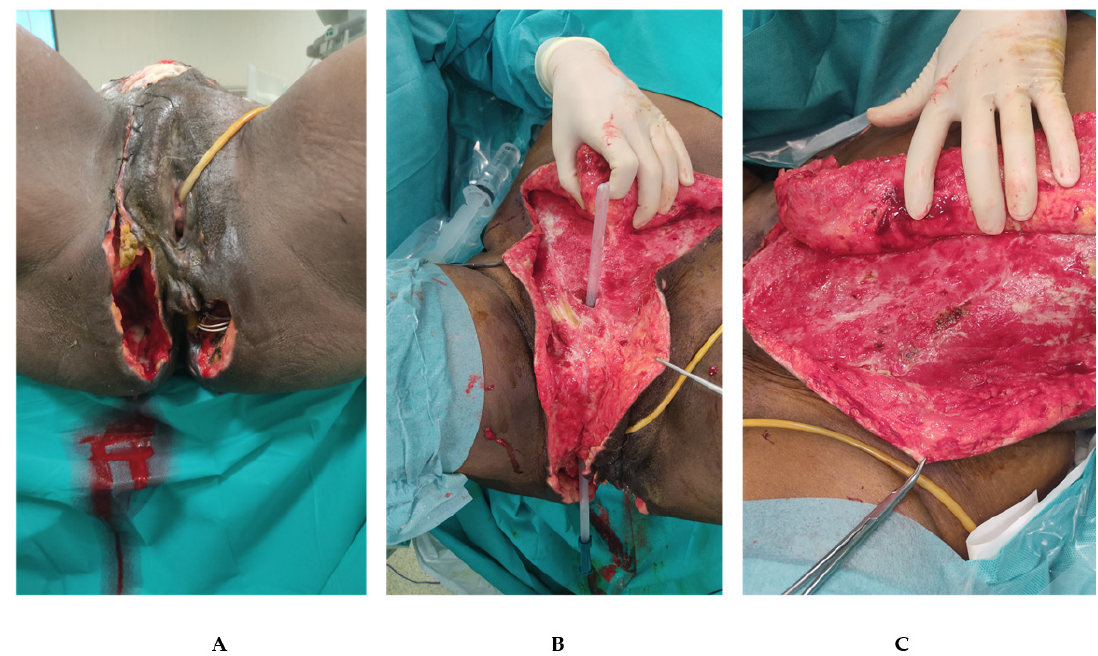
Figure 2. Patient presentation at the time of surgical debridement . ( A ): Perineal region presents bilateral cavity with skin and soft tissue necrosis. A vessel loop (with loop) was placed in the rectal fistula to underline the continuity with the left caviy. ( B ): rectal tube placed in the right inguinal canal explaining the reason for the spreading to the abdominal region of the infection. ( C ): Left flank view after the first debridement.